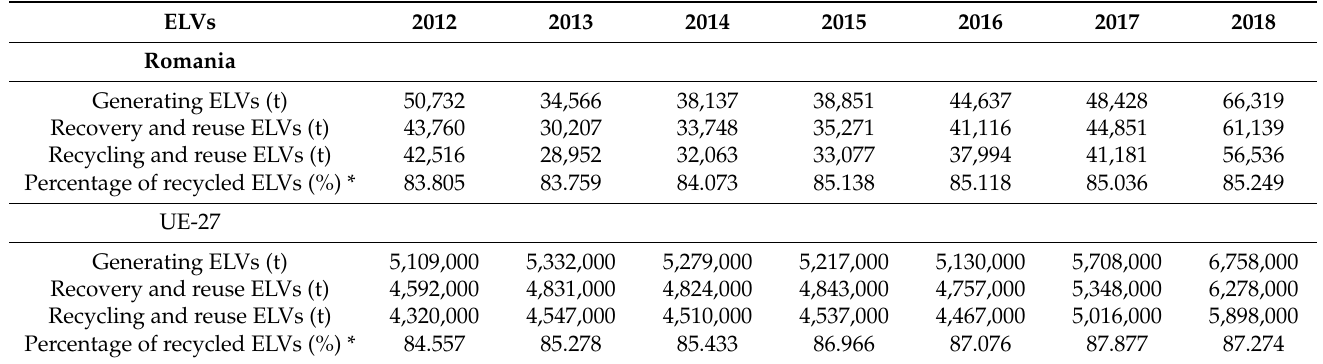
Table 6. Management of ELVs in Romania and UE-27 Table made by authors based on Eurostat data